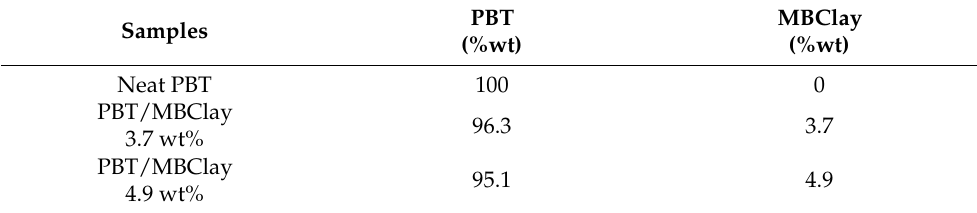
Table 2. Corrected nanocomposite compositions.